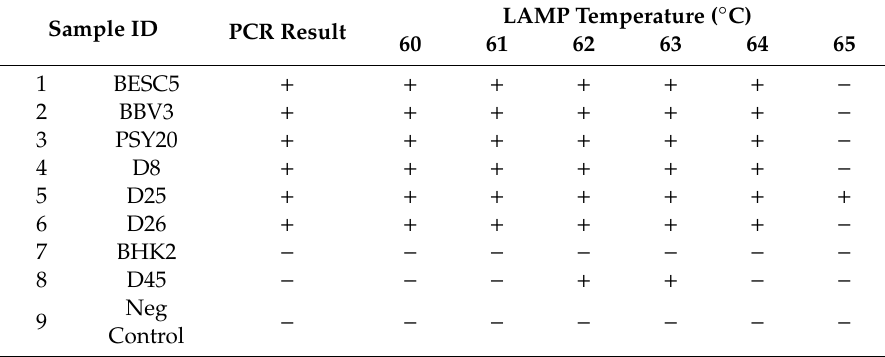
Table 2. Result of LAMP assay for E. canis using di ff erent temperatures.